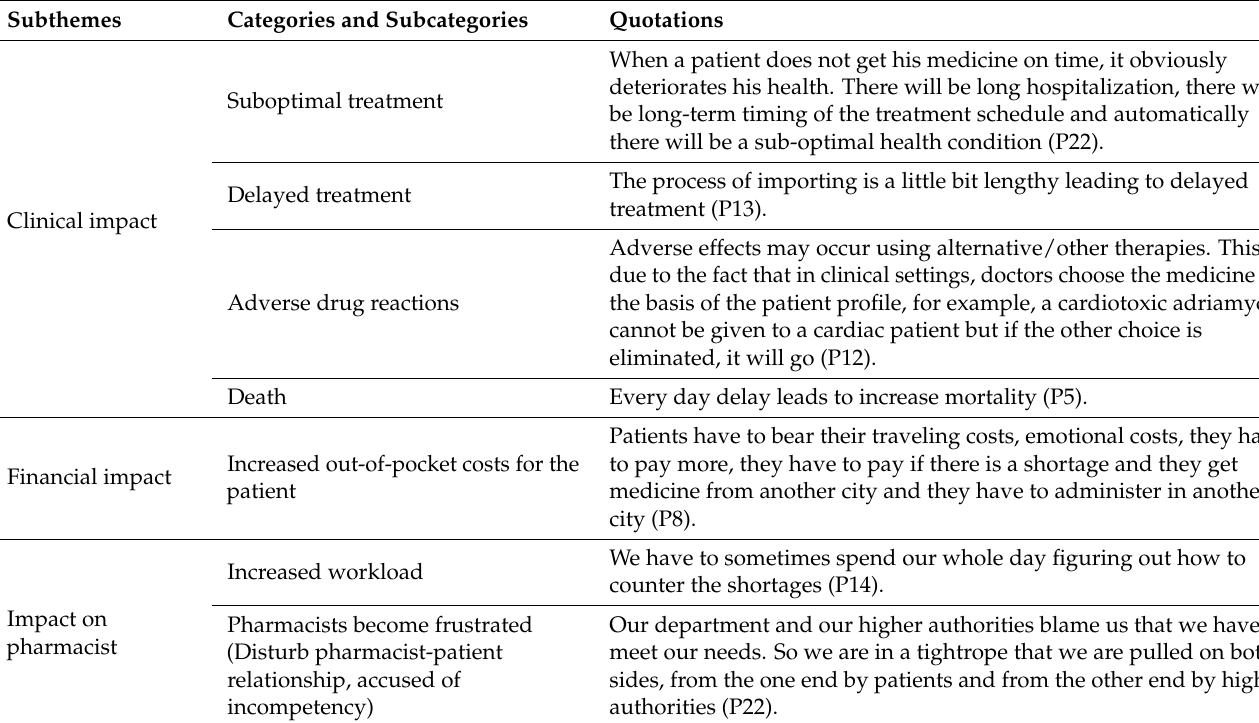
Table 4. Theme 3: